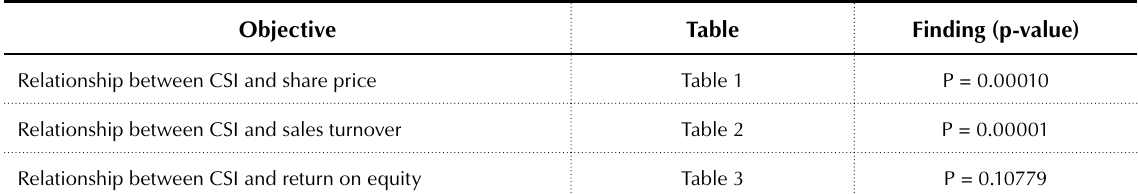
Table 4. Interpretation of results